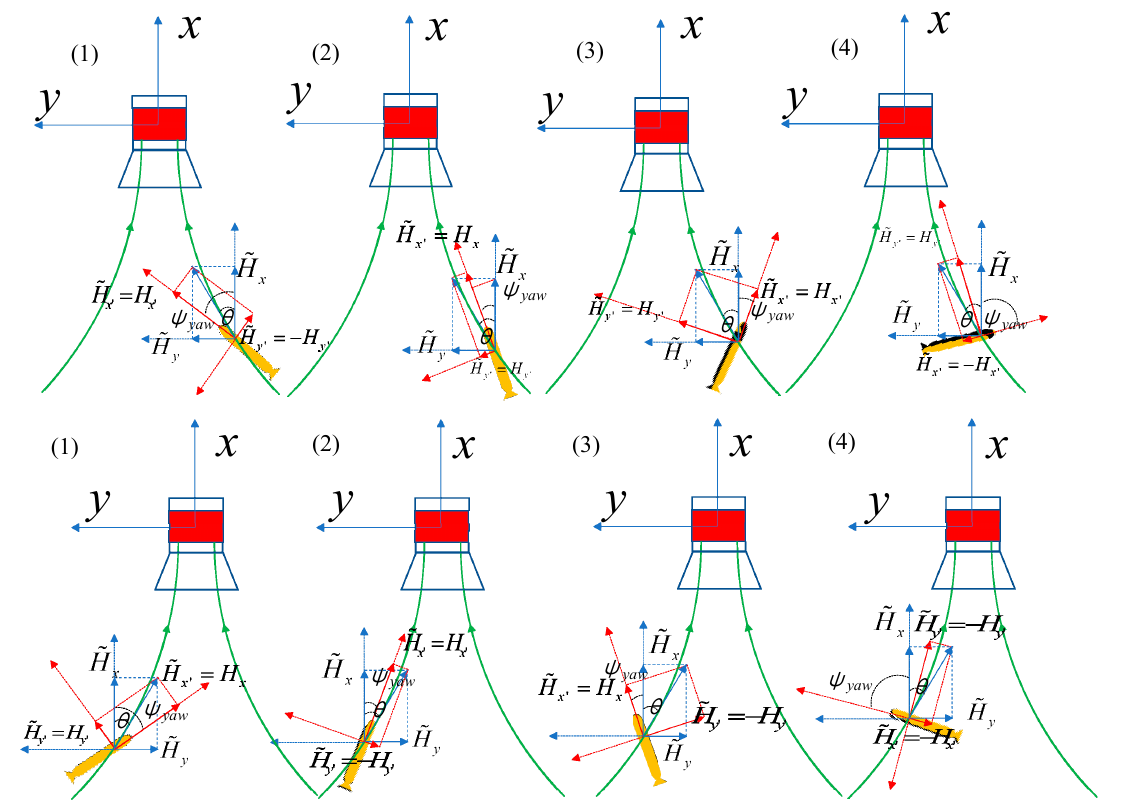
Figure 7. Distribution of magnetic field vectors at the point where the triaxial-coil magnetometer is located at time t 0 with different yaw angles ( upper : where y < 0; lower : where y > 0). . . . . H x and H x (cid:48) , the phase between H x (cid:48) and H y (cid:48) , and the calculation of Table 3. The phase between . . . . H x , H x ’ Phase between H x ’ , H y ’ Phase between